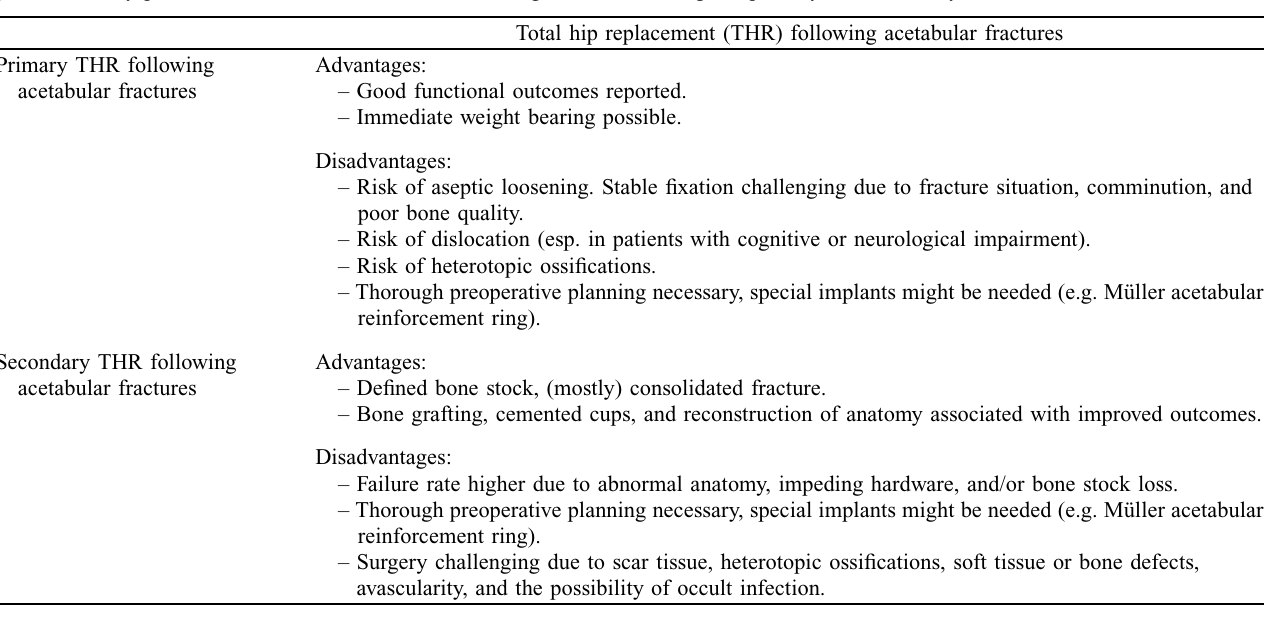
Table 1. Primary and Secondary total hip replacement (THR) following acetabular fractures. In order to define the individualized treatment plan for elderly patients with acetabular fractures, advantage and disadvantage of primary and secondary THR have to be